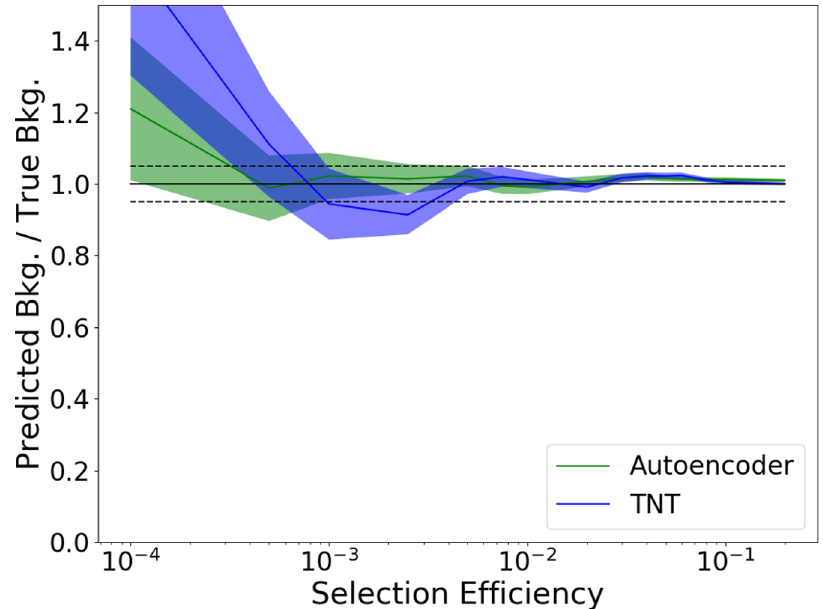
Figure 5 . A comparison of the estimated and true number of background events as a function of selection efficiency for the cut and count based analysis. The shaded regions around the cen- tral values show the 1 σ uncertainties due to the Poisson uncertainty on the observed number of background events. The black dashed lines shows a 5% around the ratio of